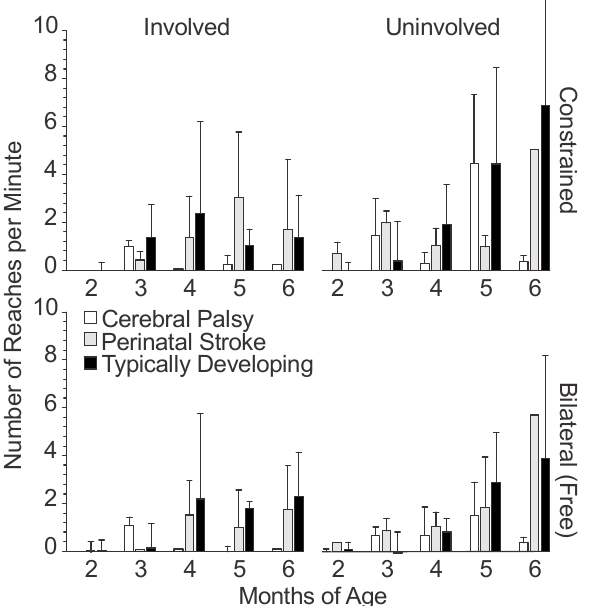
Figure 7. Mean reach frequency by age, side, and condition. For typically developing infants, the left arm is plotted alongside the involved limb and the right arm is plotted alongside the uninvolved limb. Error bars show 1 standard deviation.